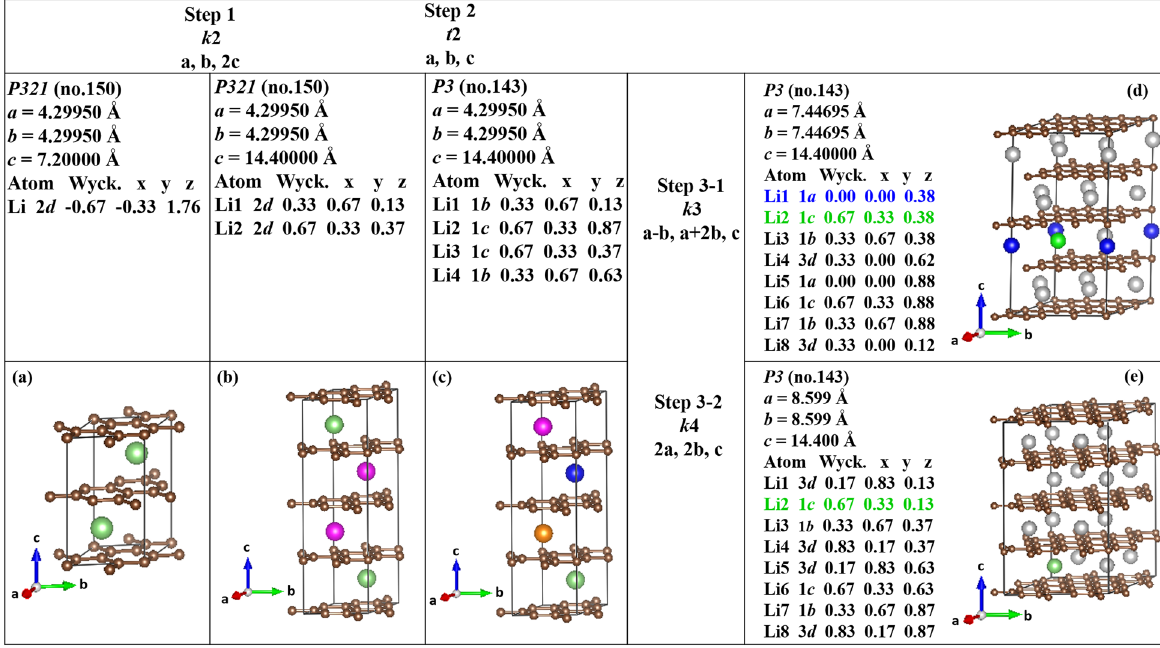
Fig. 5 Illustration of Li x C 6 ordered phases with 0.0625, 0.0833, 0.167 Li. a Parent structure of AB stacking LiC 6 b Isomorphic enlargement by a , b , 2 c . c P3 subgroup is obtained with t -index of 2. d Li 0.0833 C 6 and Li 0.1667 C 6 are obtained by a − b , a + 2 b , c . e Li 0.0625 C 6 is obtained by 2 a , 2 b , c